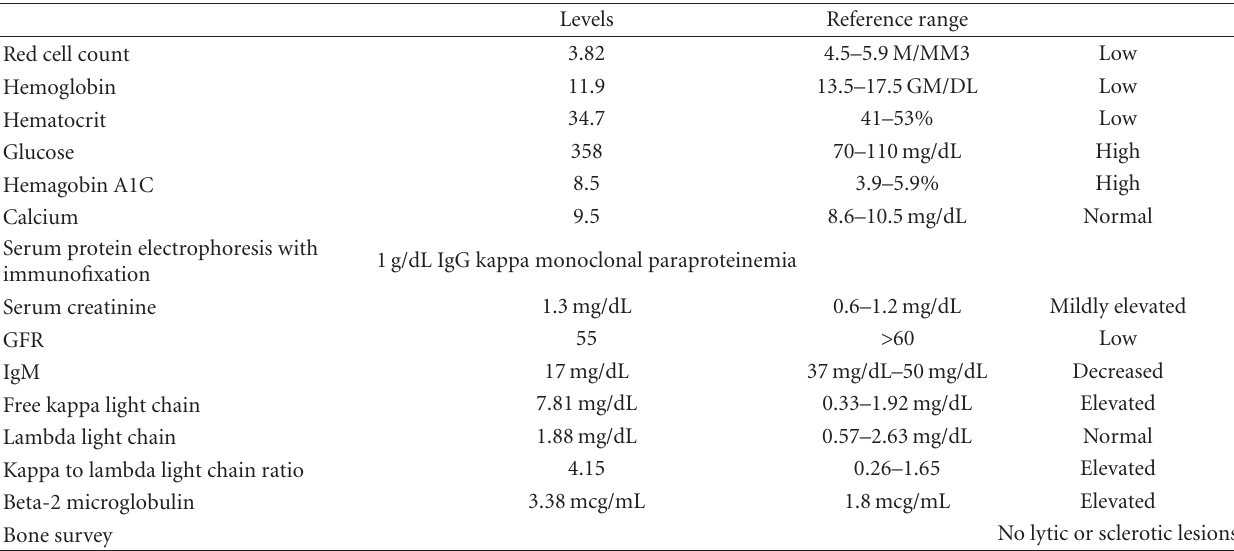
Table 2: MGUS laboratory workup of the